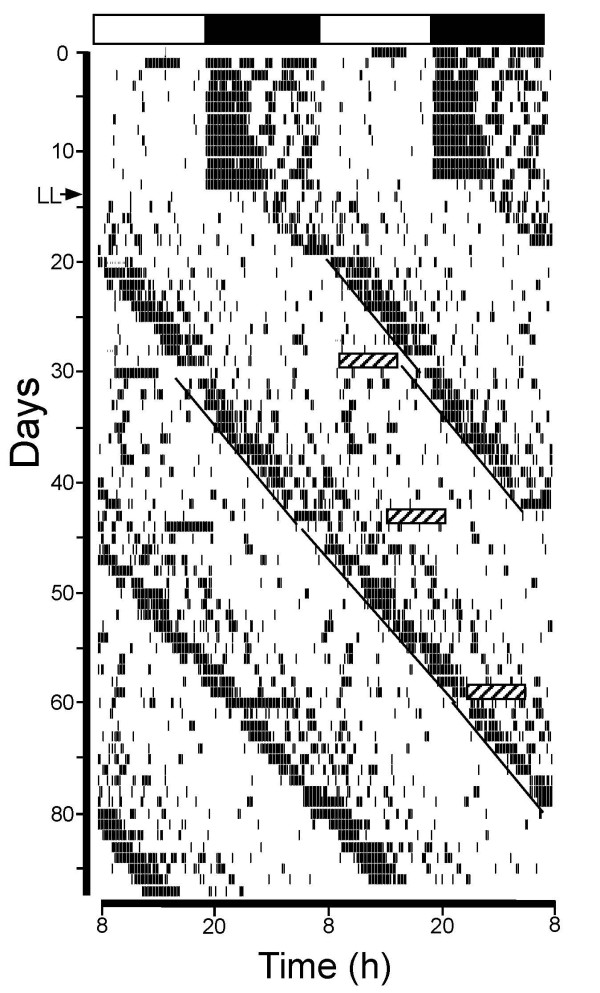
Dark pulses phase-dependently phase-reset murine wheel-running rhythms. Double-plotted wheel-running actogram showing the effects of diurnal (LD) and constant light (LL) lighting regimes and 6 h dark pulses (hatched boxes) on the behavioral activity of a C57BL/6J mouse. Horizontal bar at the top of the actogram depicts the lights-on (unfilled) and lights-off (filled) cycle. Arrow indicates the transfer from LD to LL and black bars indicate locomotion in a running-wheel equipped cage. The solid black lines indicate the onset of the main bout of wheel-running activity (in LL; CT12 convention). The first dark pulse was centered at ~CT6 and elicited a 1.27h phase advance. Subsequent dark pulses delivered at ~CT22 and ~CT13 had negligible phase-shifting effects.